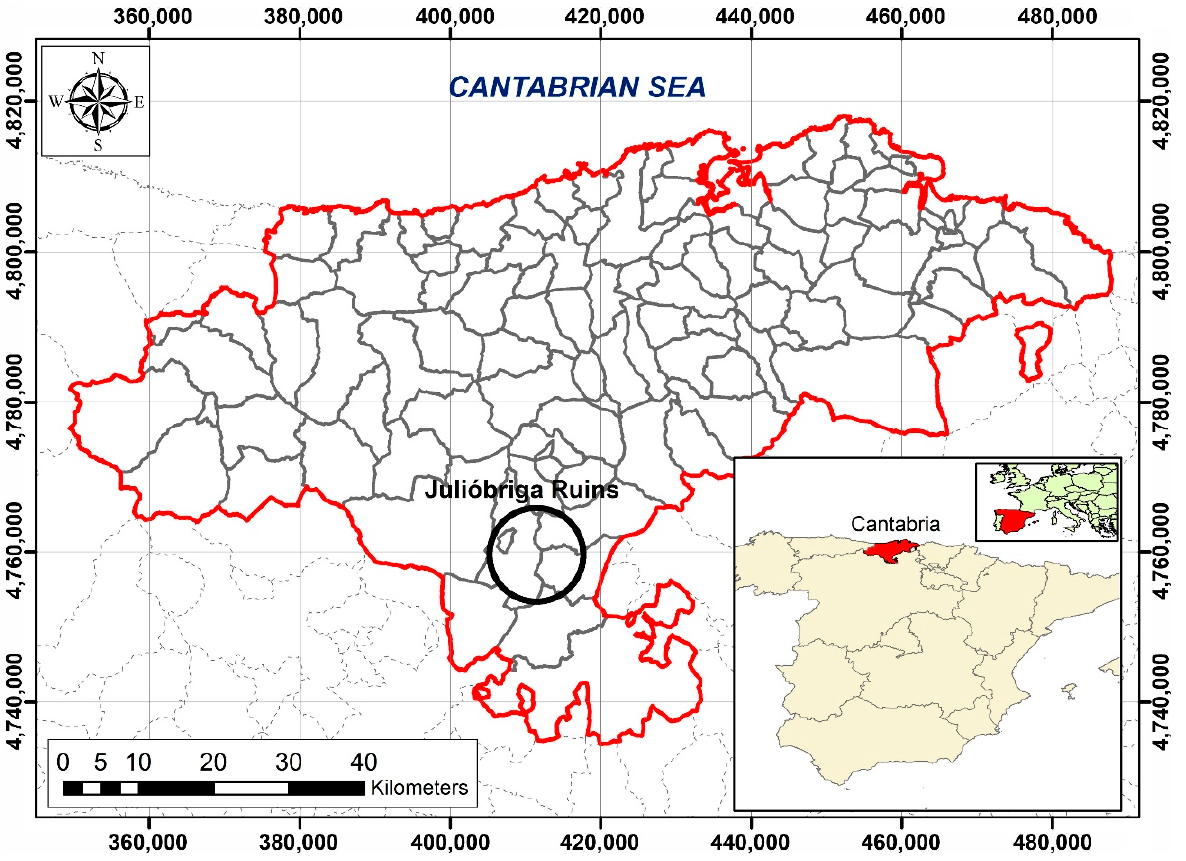
Figure 1. Location of Juliobriga.